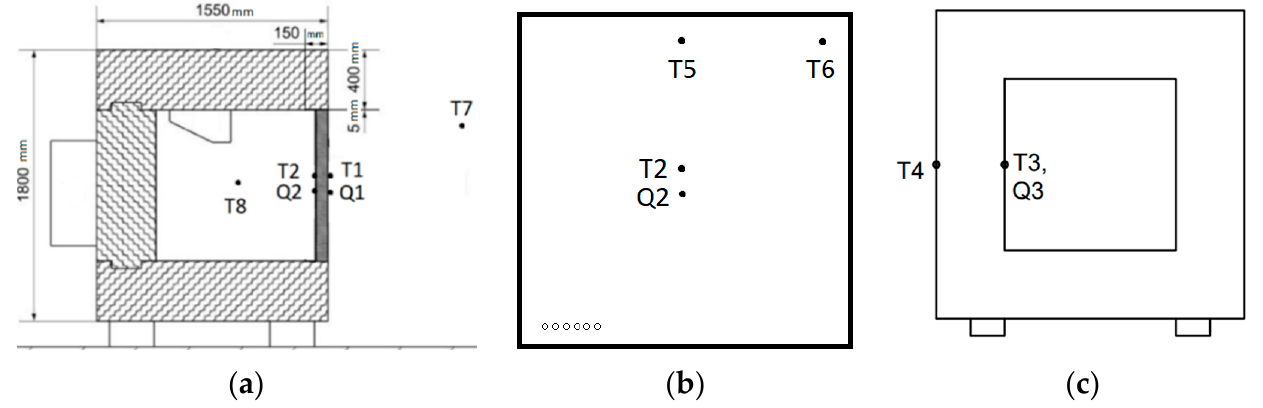
Figure 5. Location of the sensors during the tests: ( a ) cross-section view; ( b ) view from the inside of the tested wall; ( c ) front view.